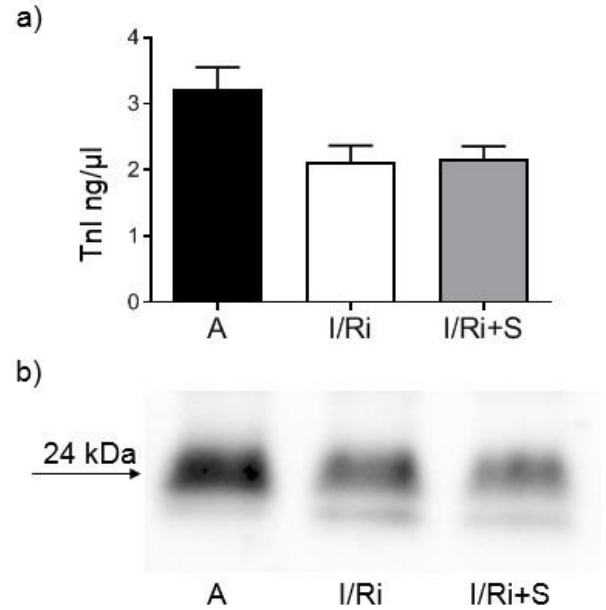
Figure 8. Effect of simvastatin on Troponin I content in hearts subjected to ischemia-reperfusion. ( a ) Analysis of Troponin I content in heart homogenates determined by Western blot. There were no significant differences in troponin I content in heart tissue. n = 5–6, ANOVA. ( b ) Representative blot showing the Troponin I level in heart homogenates determined by Western blot. A—aerobic perfusion, I/Ri—ischemia-reperfusion injury, I/Ri + S—hearts from IR injury model treated with